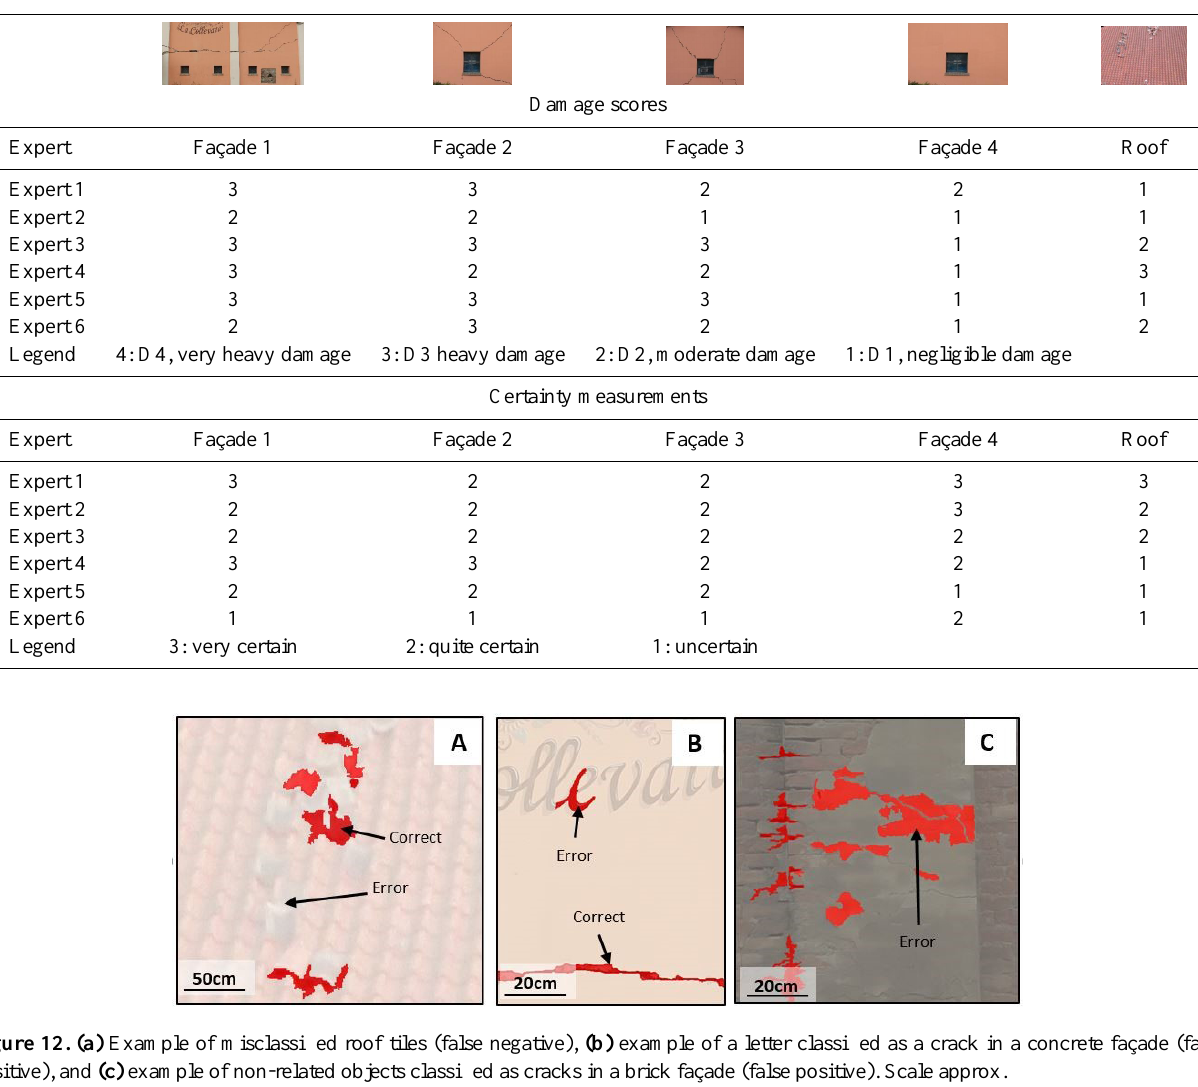
Table 3. The collected damage scores and certainty measurements from the six experts that carried out the interface test in Fernandez Galarreta (2014).